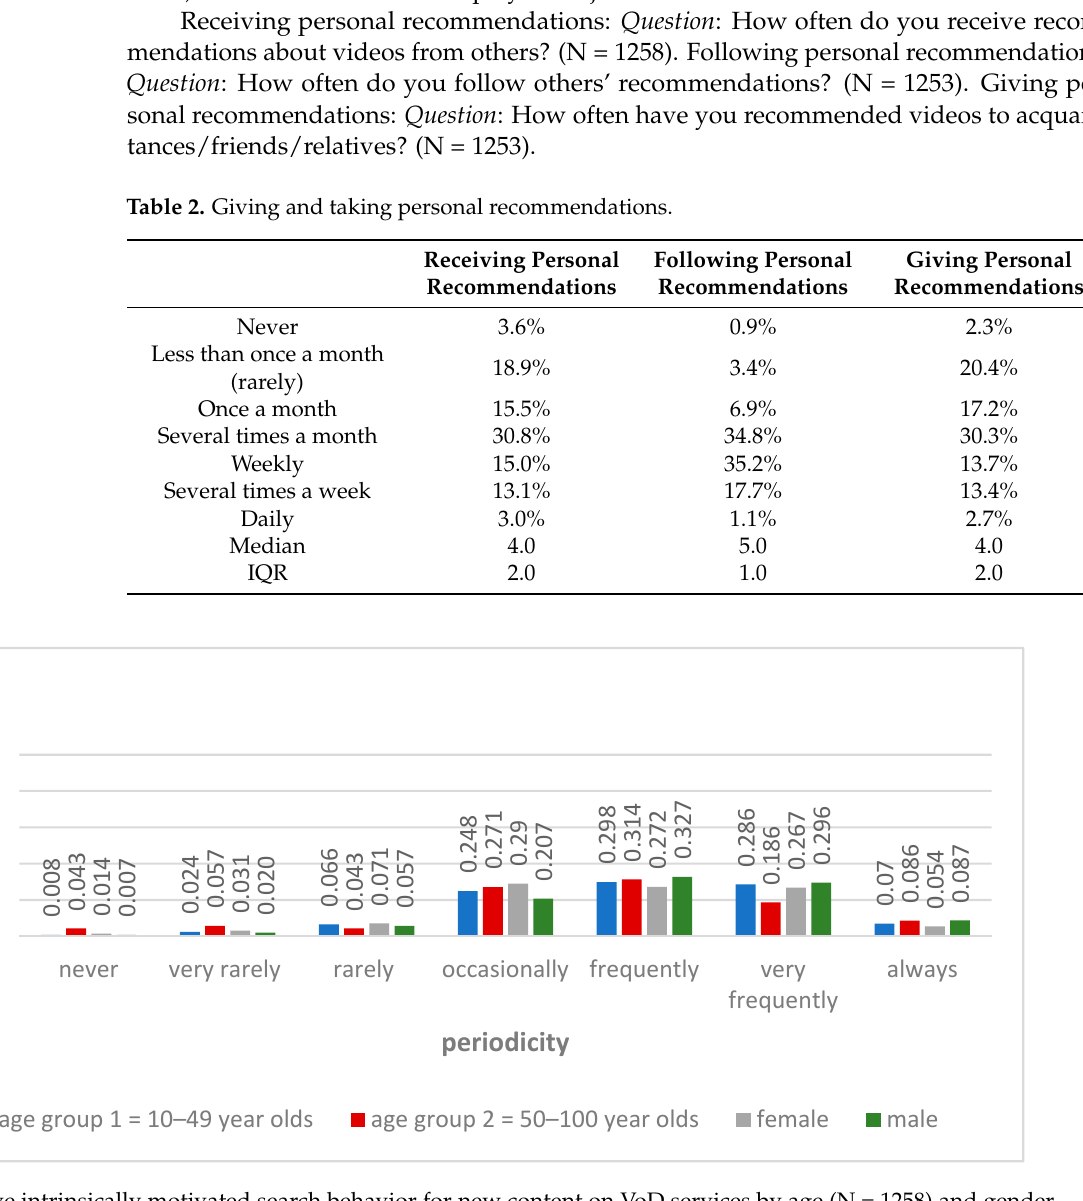
Figure 3. Active intrinsically motivated search behavior for new content on VoD services by age (N = 1258) and gender (N = 1253) (relative frequencies). Question: How often do you search for new videos?